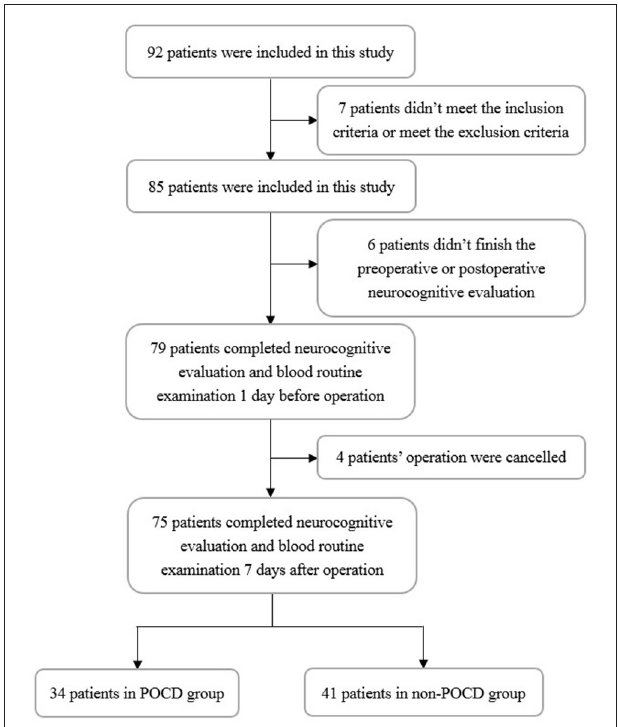
FIGURE 1 | The process flow diagram of the experiment. POCD, postoperative cognitive dysfunction.